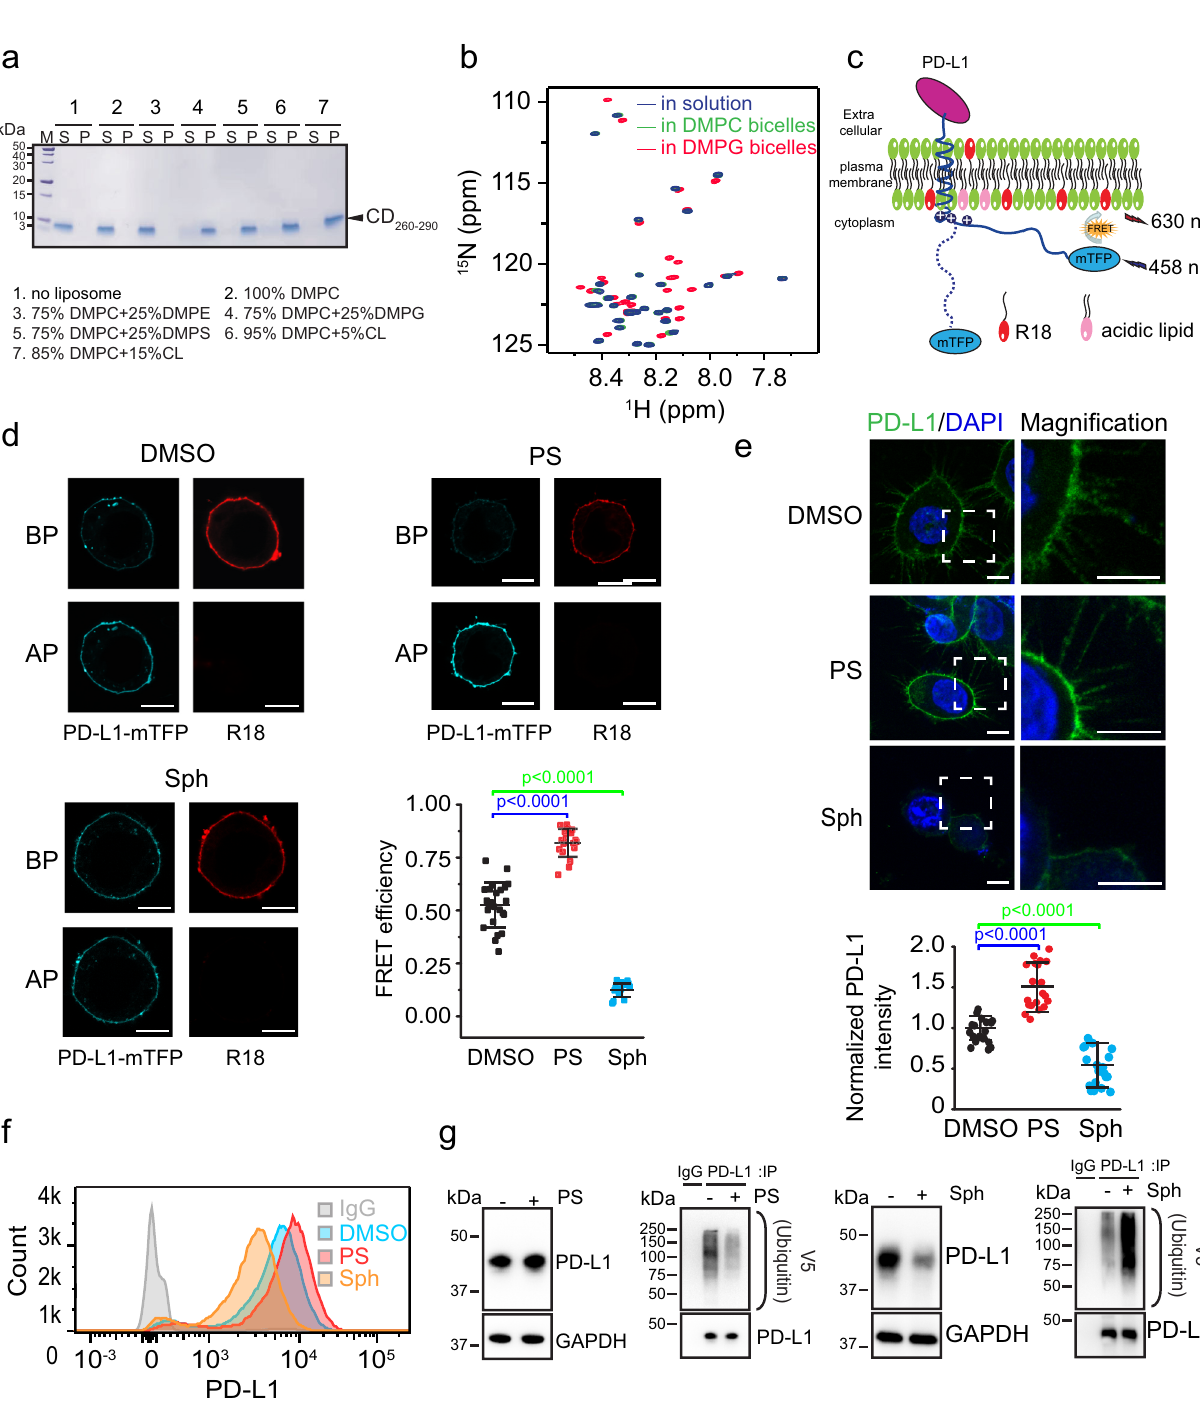
the content of acidic lipids in the plasma membrane 27 , a higher FRET ef fi ciency was detected compared to the solvent-treated cells, indicating stronger interactions between PD-L1-CD and the membrane with more acidic phospholipids (Fig. 1d). This result was further con fi rmed by the FRET ef fi ciency determined using the donor quenching approach (Supplementary Fig. 3). In addition, a lower FRET ef fi ciency was obtained when the RKO cells were treated with sphingosine (Sph, a membrane-permeant base) 27 , as expected for the reduced negativity of the plasma membrane by Sph (Fig. 1d). The effects of PS and Sph on the endogenous PD-L1 level on the RKO cell surface were further examined by confocal imaging